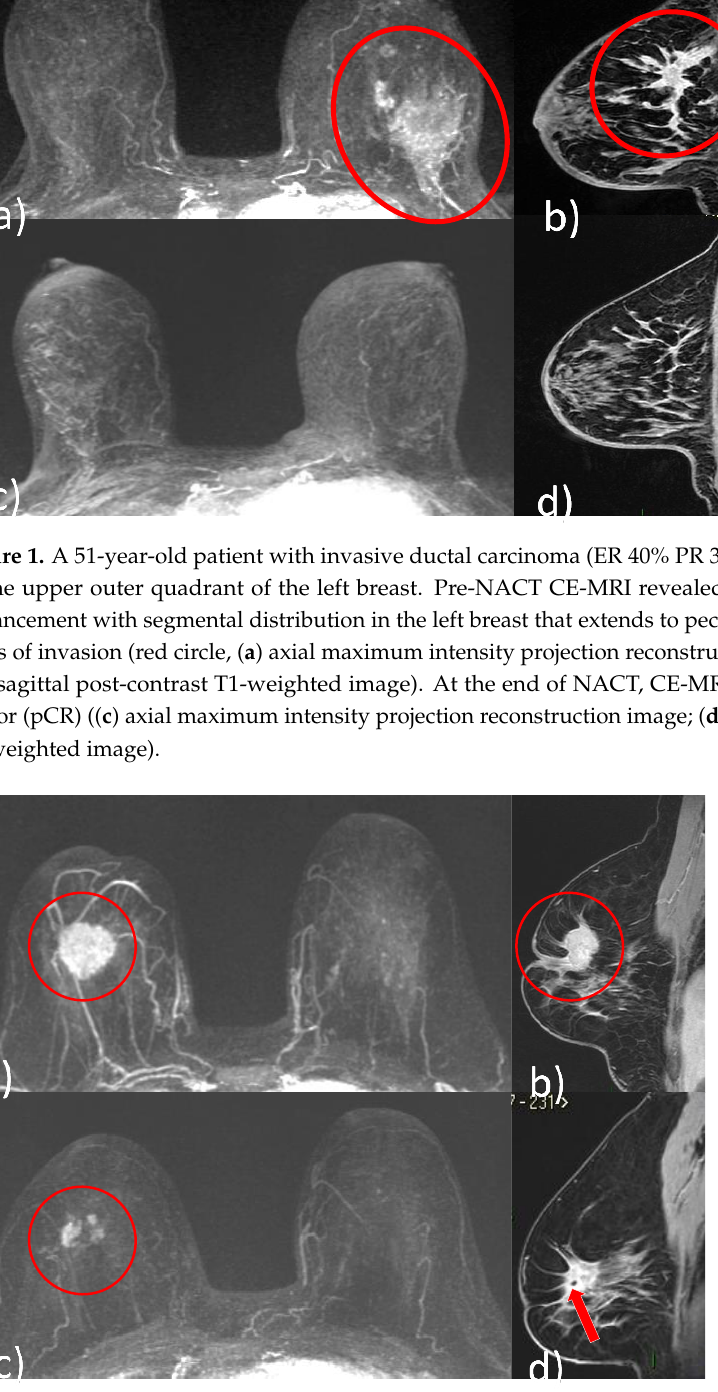
Figure 2. A 48-year-old patient with G2, luminal B, HER2 positive right breast cancer undergoing NACT. Pre-treatment breast CE-MRI showed an oval mass with irregular margins, nipple invasion and skin retraction at the junction of upper quadrants of the right breast (red circle, ( a ) axial maximum intensity projection reconstruction image) (red circle, ( b ) sagittal post-contrast T1-weighted image). After NACT, multifocal shrinkage was depicted by CE-MRI (red circle ( c ), axial maximum intensity projection reconstruction image). ( d ) Signal void artifact caused by tissue marker clip inside the residual mass is well visible on the sagittal T1-weighted post-contrast image (red